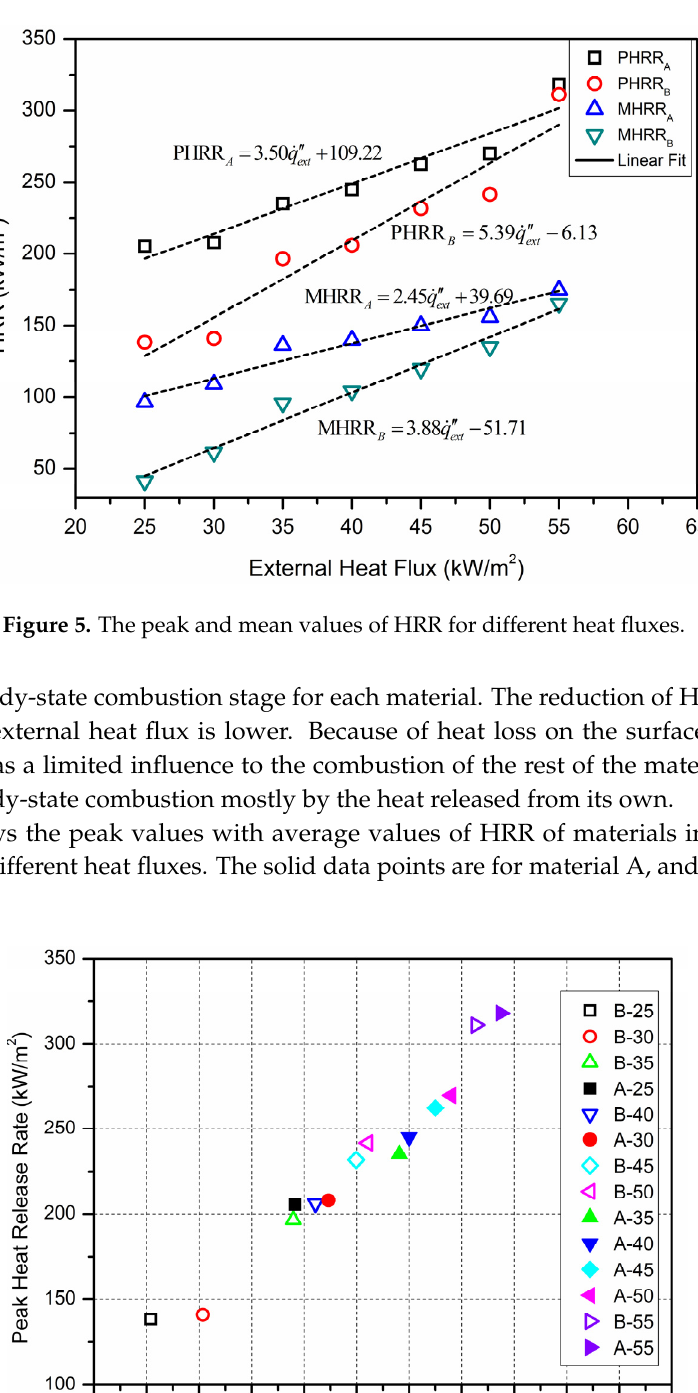
tested at heat flux varying from 25 kW/m 2 to 55 kW/m 2 with a step of 5 kW/m 2 , and a clear linear Figure 6. Plot of PHRR against MHRR for the material A and B tested at different external heat fluxes.